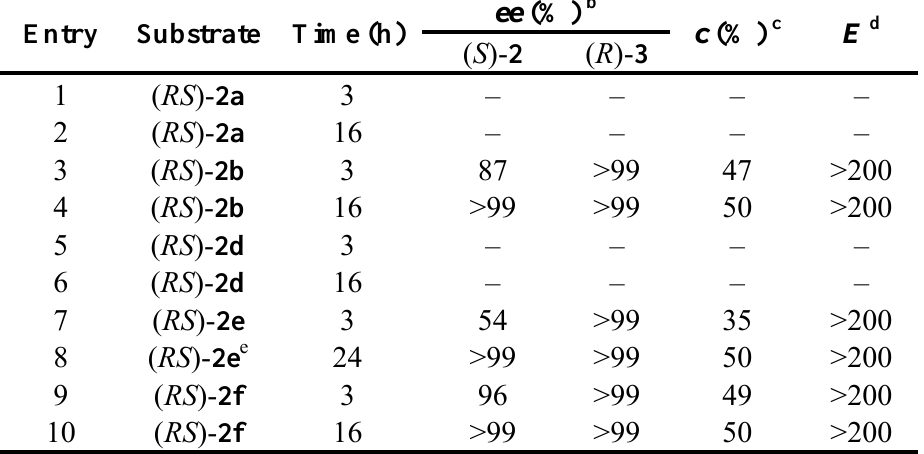
Table 3. Enzymatic kinetic resolution of aryltrimethylsilyl chiral alcohols 2a , b , d , e , f a